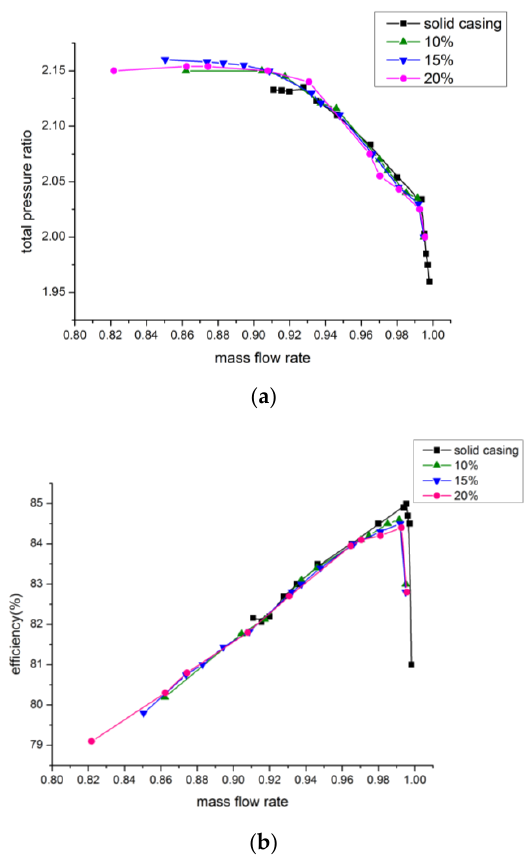
Figure 8. Characteristic curves for solid wall casing and axial slots of different areas ( a ) total pressure ratio characteristic curves; ( b ) efficiency characteristic curves.